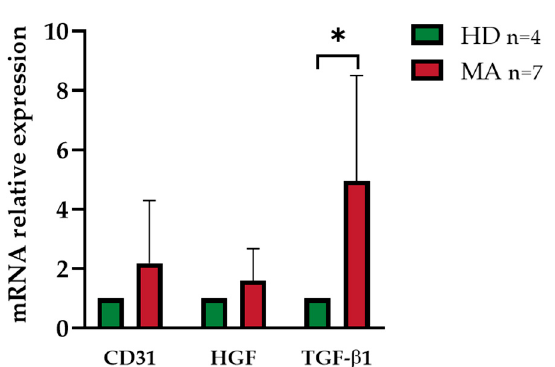
Figure 9. mRNA relative expression of CD31 , HGF , and TGF- β 1 in EPCs at 7 days after seeding: The mRNA levels in EPC from MA patients are expressed in relation to HD subjects, arbitrarily imposed at 1 as calibrator. β 2M was used as housekeeping gene. Data were expressed as mean ± SD, and statistical significance (* p < 0.05) was calculated through Student’s t -test. Values of at least three independent experiments are shown.